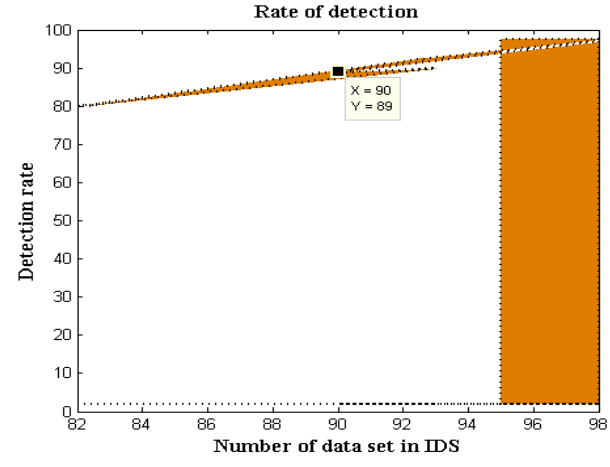
Figure 13. Analysis of FAR.